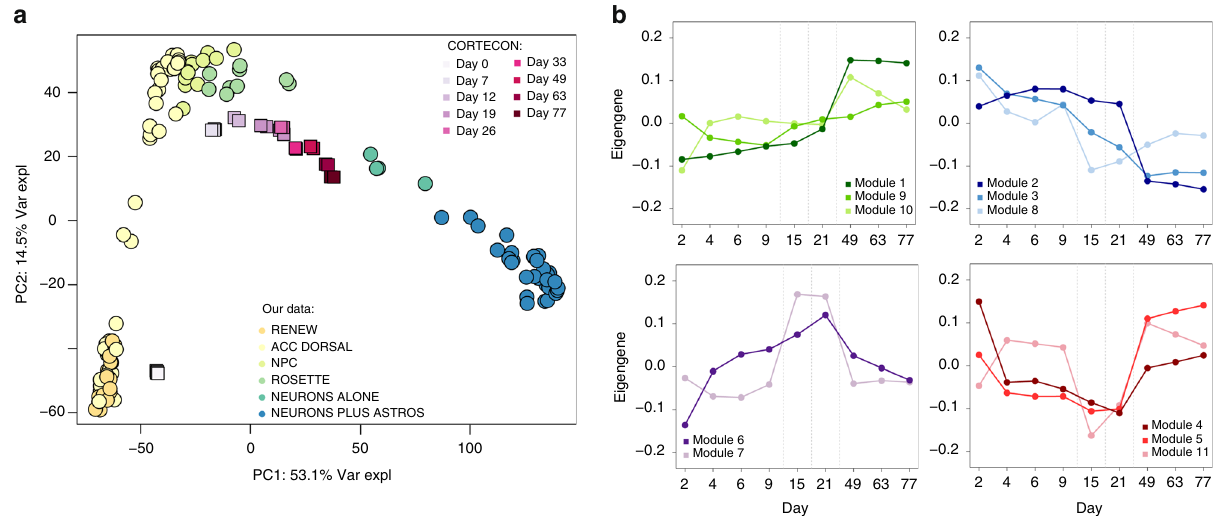
Fig. 2 Global expression comparison to CORTECON. a PCA of gene expression levels showing PC1 (53.1% of variance explained) representing corticogenesis and PC2 (14.5% of variance explained) separating samples in the NPC stage from self-renewing and neuronal cells, as well as the conservation of these components of variability in the CORTECON dataset. b Eigengenes of the 11 WGCNA modules created from the RNA-seq data of 25,466 expressed genes (with 3284 genes in the unassigned module), grouped by dynamic expression pattern: genes that are more highly expressed in mature neurons, those that are more lowly expressed in mature neurons (related to loss of pluripotency), those that rise in NPCs and then fall, and those that fall in NPCs and then rise again in neurons.